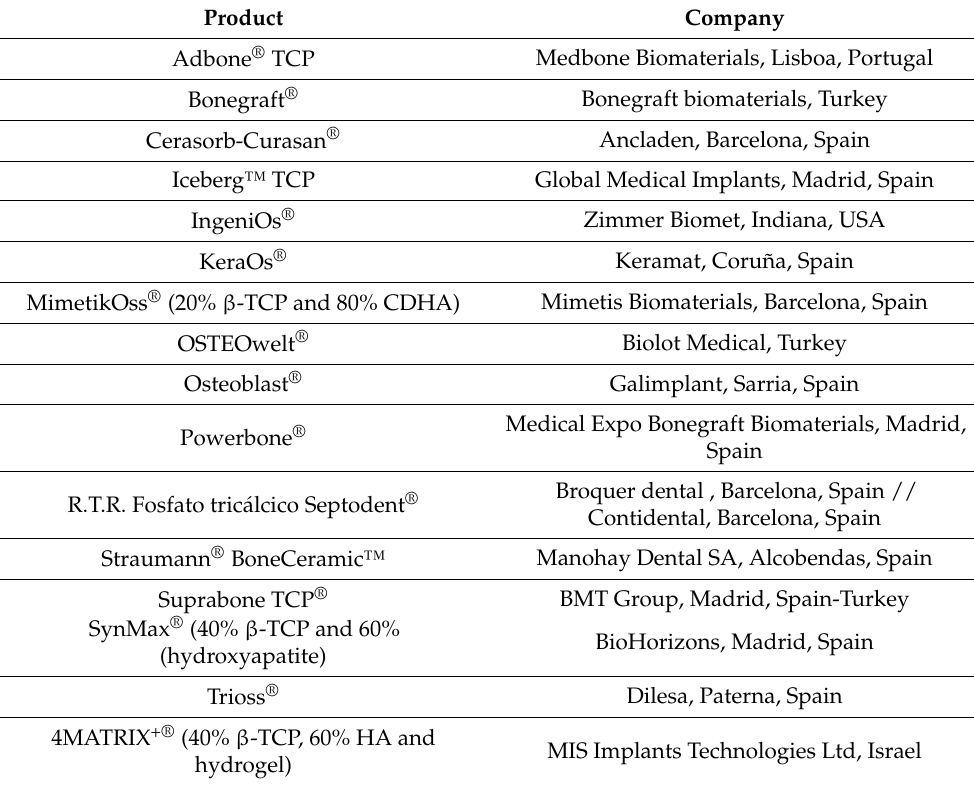
Table 3. Most common commercialized β -TCP products (in Spain). Abbreviations: β -TCP, beta- tricalcium phosphate; CDHA, calcium-deficient hydroxyapatite; HA, hydroxyapatite.